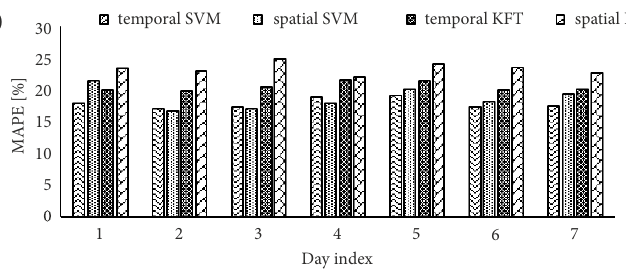
Figure 4. Performance comparison of peak and off-peak conditions: a – performance comparison over trips that happened on a sample day; b – MAPE comparison for various days Table 4. Correlation coefficients obtained for various prediction methods for high variability